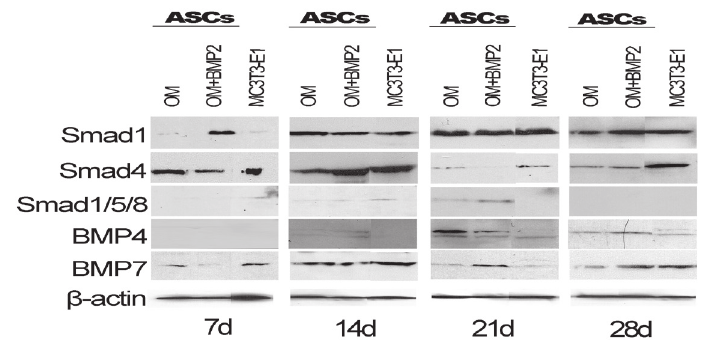
Figure 3- Expression of osteoblast related proteins. Protein expression evaluated by western blotting, at days 7, 14, 21, and